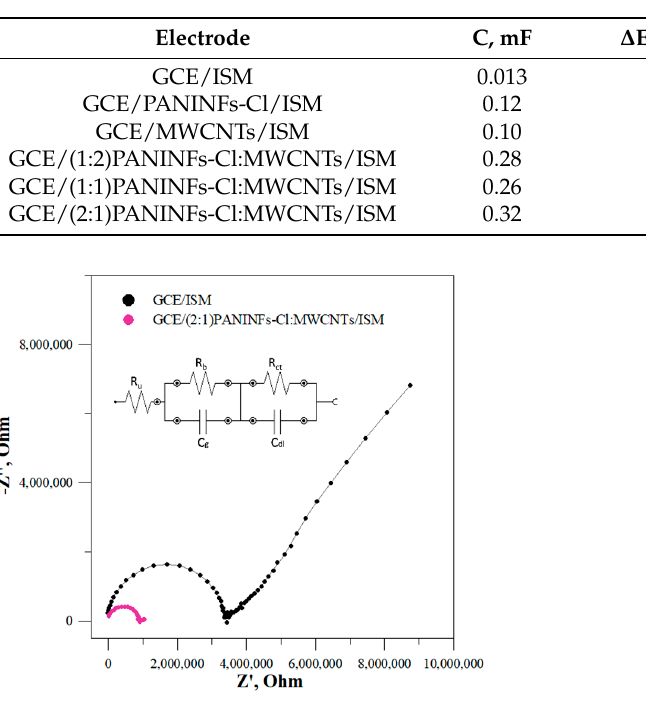
Figure 4. Chronopotentiometric curves obtained for the electrodes: ( A ) unmodified GCE/ISM and with intermediate layers of nanofibers GCE/PANINFs-Cl/ISM or nanotubes GCE/MWCNTs/ISM; ( B ) unmodified GCE/ISM and with intermediate layers of nanocomposites. Table 3. Estimated values of electric capacitance (C) and resistance (R) for the tested electrodes determined by chronopotentiometry.